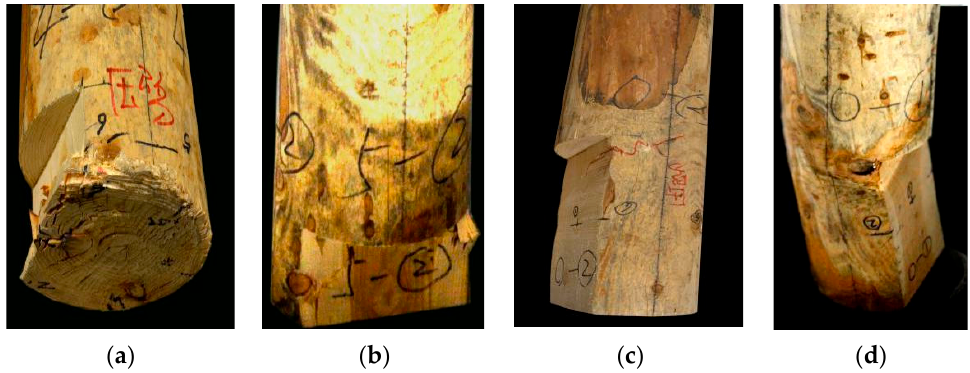
Figure 17. Load failure mode of sapwood reduction: ( a ) Bottom fold appears; ( b ) Local strip fracture; ( c ) Externally visible twill damage; ( d ) Serious bending deformation.